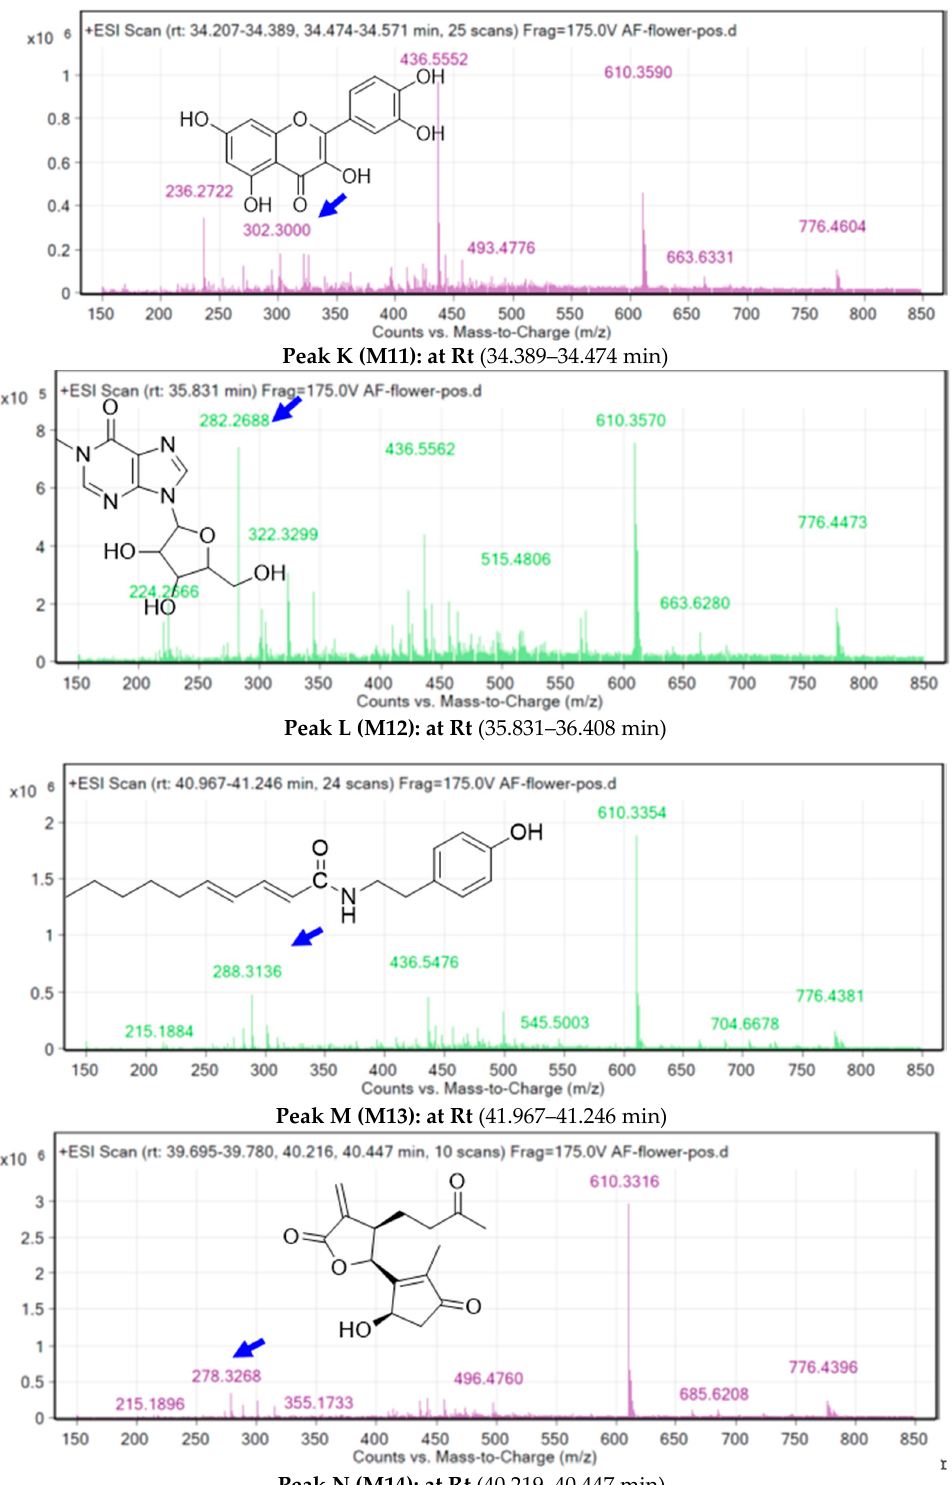
Figure 7. The identification of A. fragrantissima flower dichloromethane extract metabolites using an Agilent LC-QTOF in positive and negative modes.